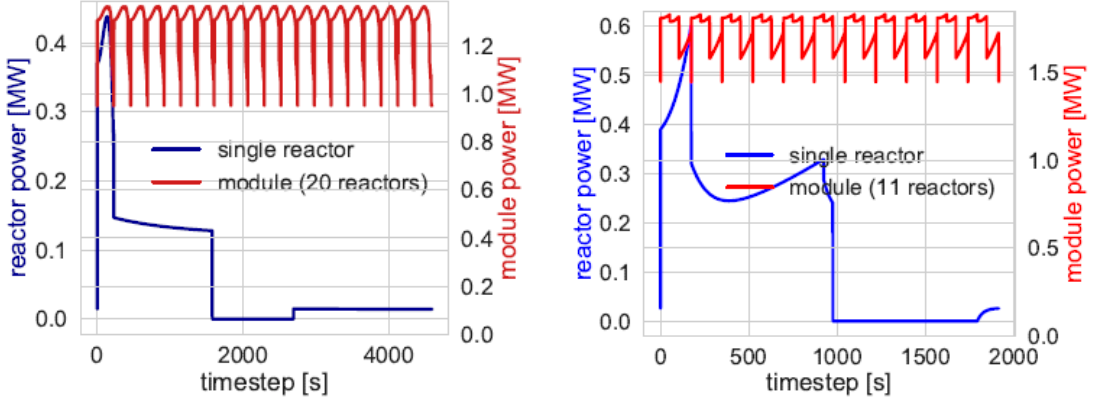
Figure 7. Solar power requirement for a single reactor and for a module (left: nickel-ferrite, right: ceria).